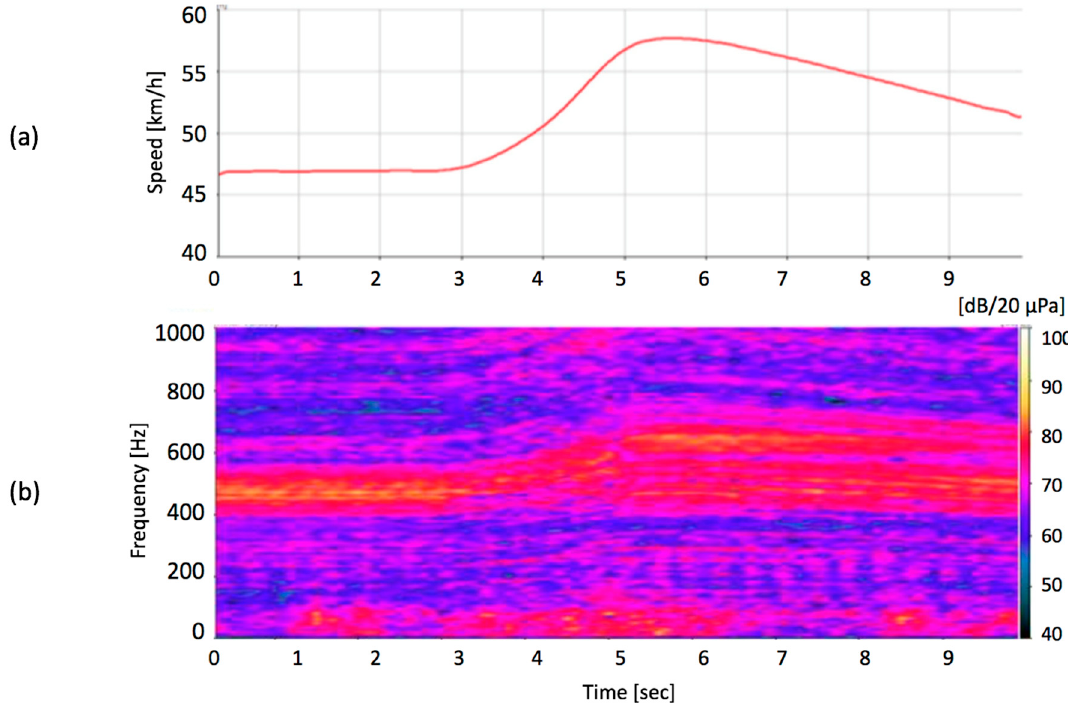
Figure 2. ( a ) Top figure is vehicle speed versus time; ( b ) bottom figure is tire noise spectrum versus time (modified from Schuhmacher, 2015 [33], Figure 12).